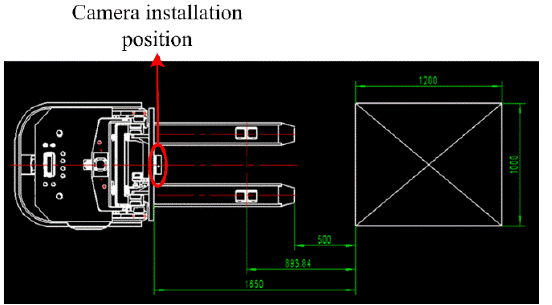
Figure 8. Relative position of unmanned industrial vehicle and pallet in standard state.